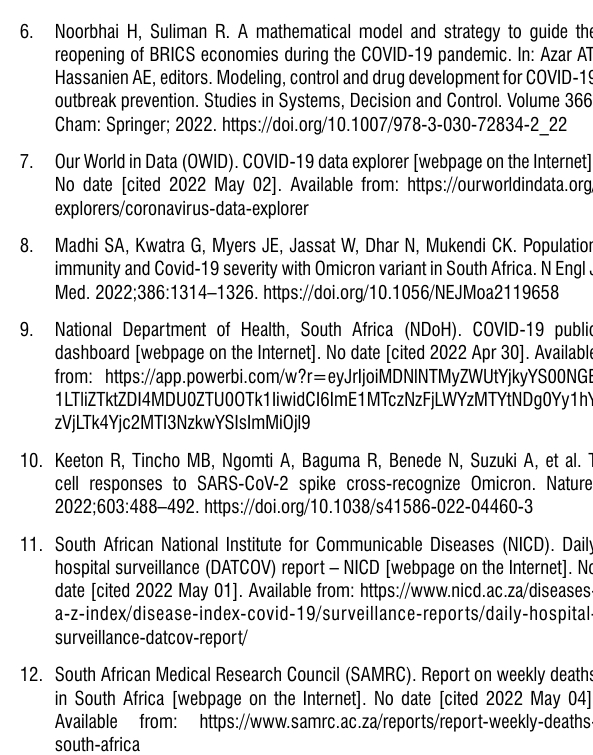
Comparison of daily COVID-19 cases and reported deaths in South